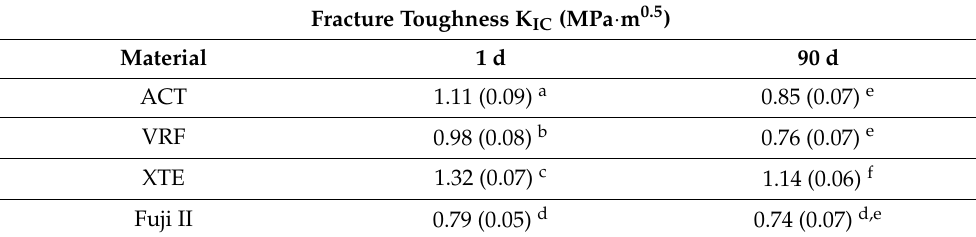
Table 3. Fracture toughness (mean and standard deviation) after 1 and 90 days of storage in water.